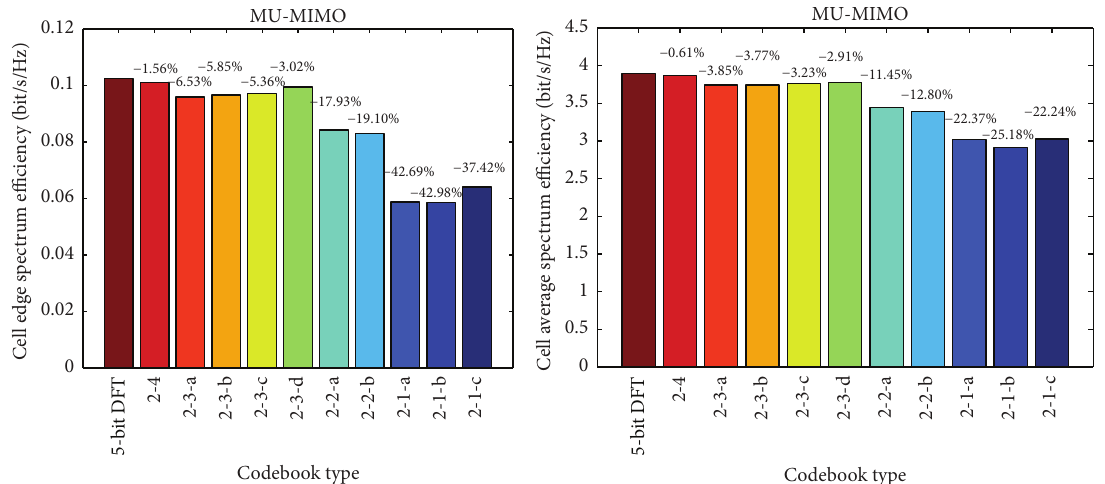
Figure 9: Simulation results of the codebooks for the vertical domain under 3D-UMi scenario.